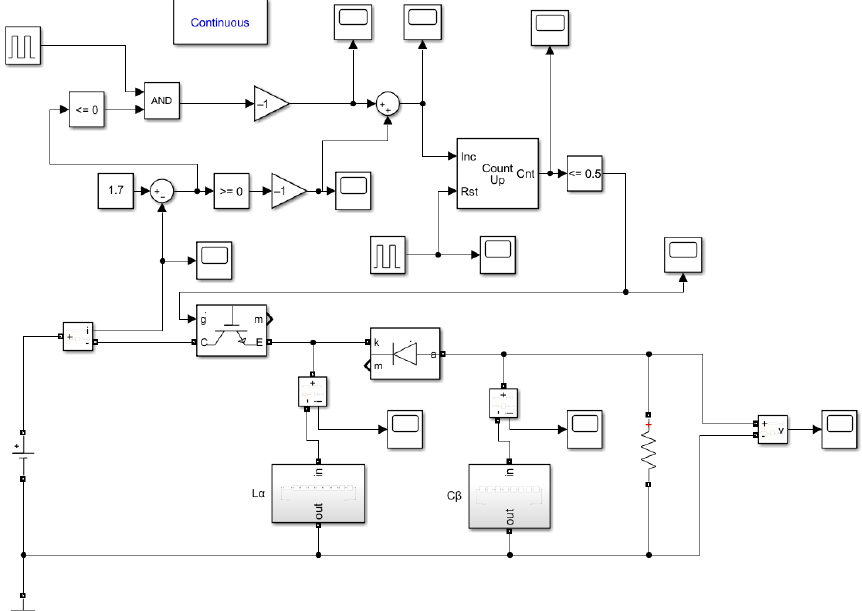
Figure 3. The mathematical model of the FO buck – boost converter. Table 1. The circuit parameters.